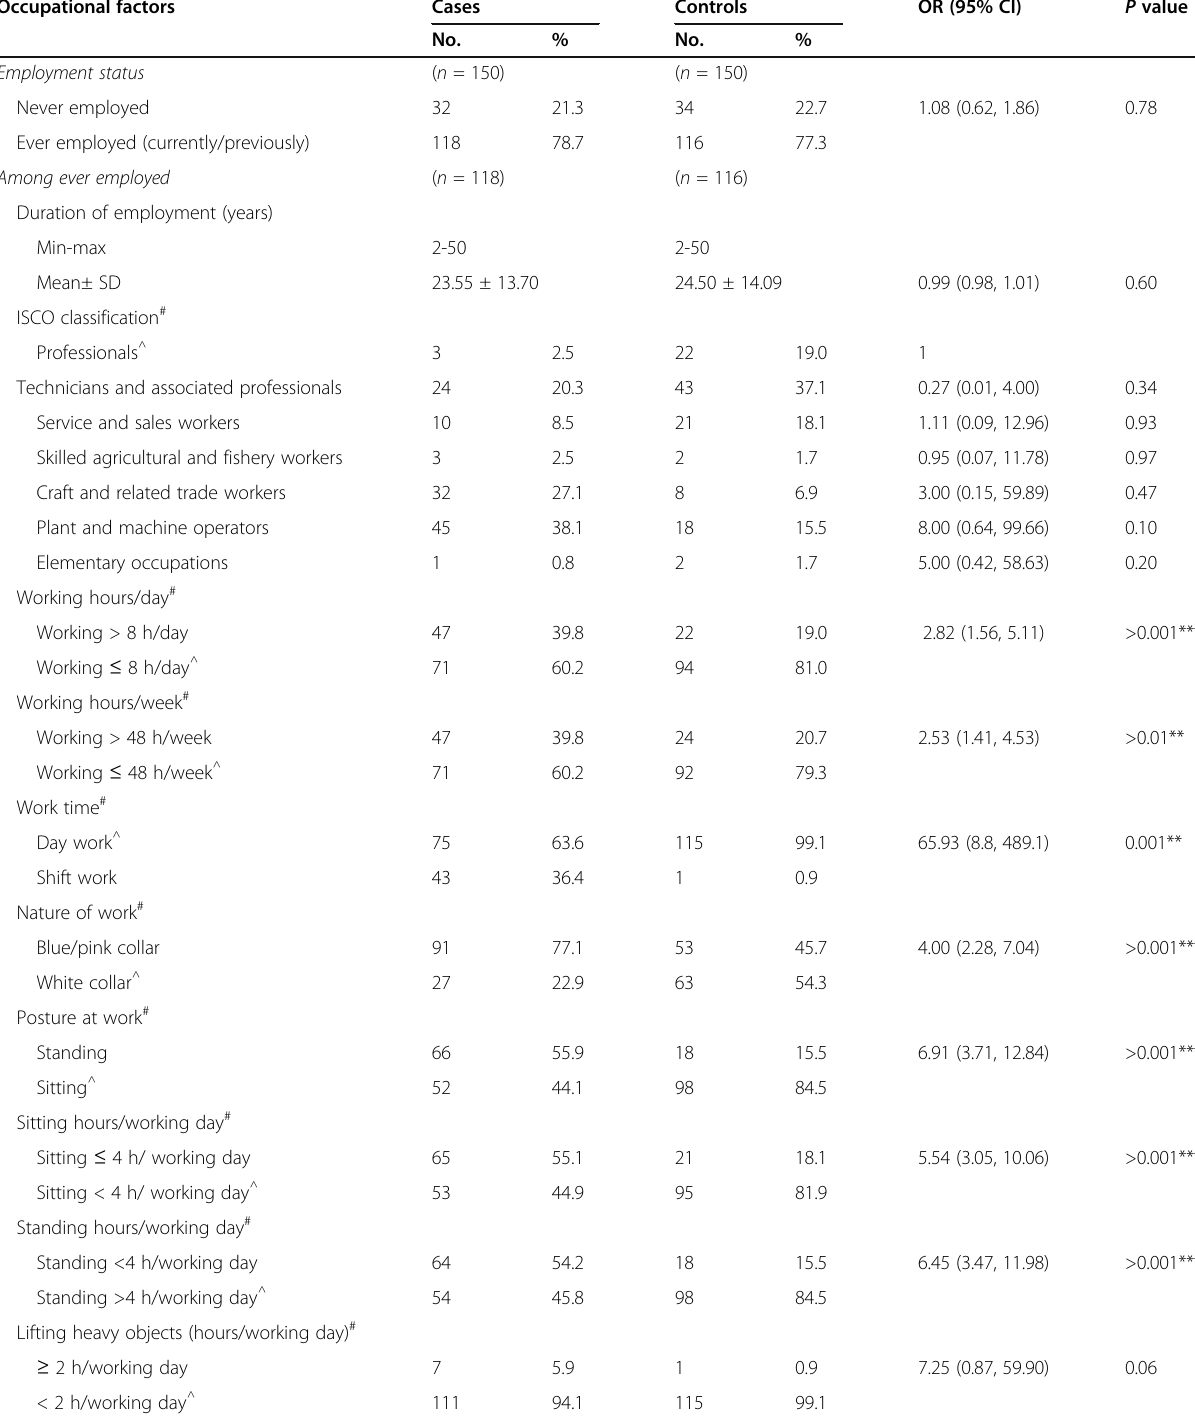
Table 3 Occupational factors associated with lower limbs varicose veins